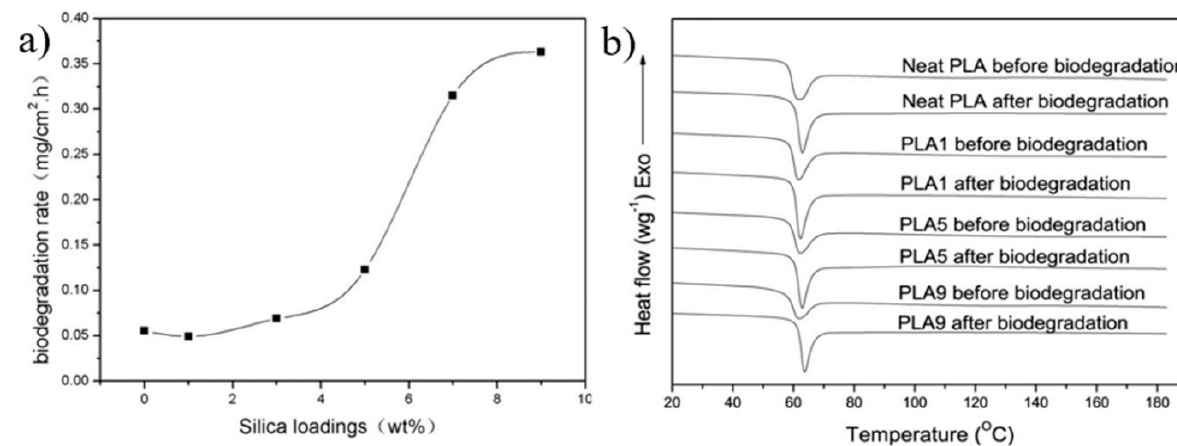
Figure 7. ( a ) The effect of silica content on the biodegradation rate of PLA/silica composites. ( b ) The DSC curves of the PLA/silica composites before and after degradation of 24 h [50].